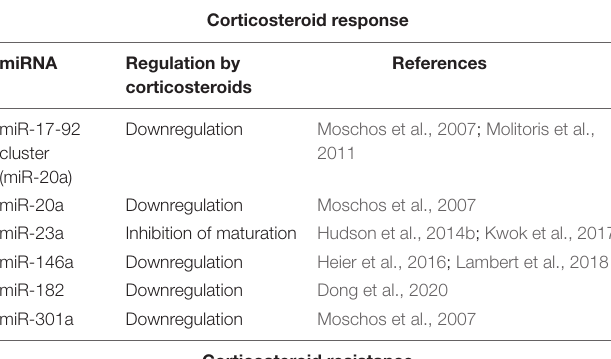
TABLE 2 | miRNAs involved in response to pharmacological treatment in VKH and corticosteroid